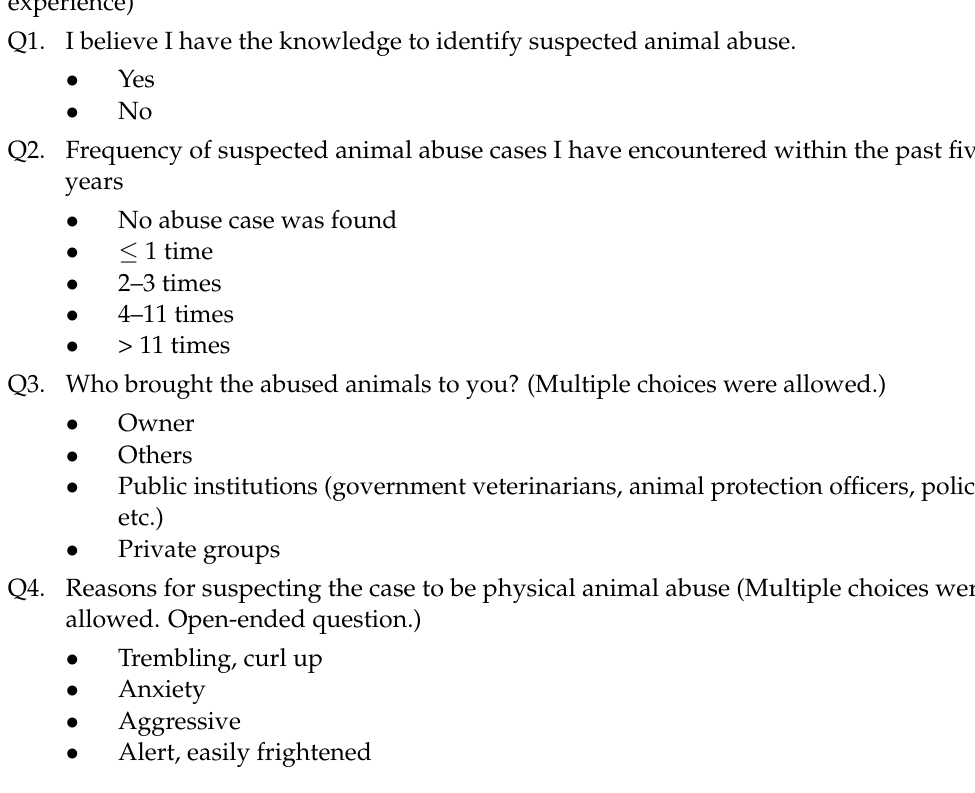
Section 5: Mental animal abuse (limited to veterinary practitioners who had the clinical